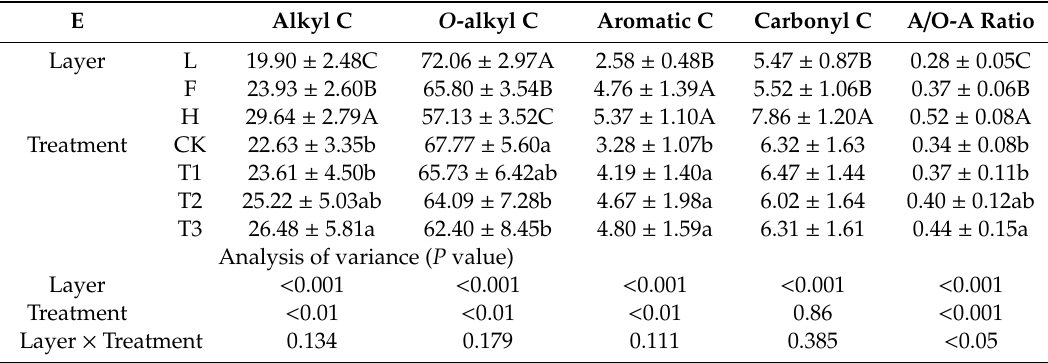
Analysis of variance ( P value) Layer < 0.001 < 0.001 < 0.001 < 0.001 < 0.001 Treatment < 0.01 < 0.01 < 0.01 < 0.001 Layer × Treatment 0.134 0.179 0.111 0.385 <0.05 L, litter layer; F, fermentation layer; and H, humified layer. CK, control treatment; T1, pH = 4.0 treatment; T2, pH = 3.5 treatment; and T3, pH = 3.0 treatment. Values are means ± SD. Different superscript letters in the column indicate significant differences among litter residue decomposition layers (uppercase letters) and differences among SAR treatments (lowercase letters) at P < 0.05.